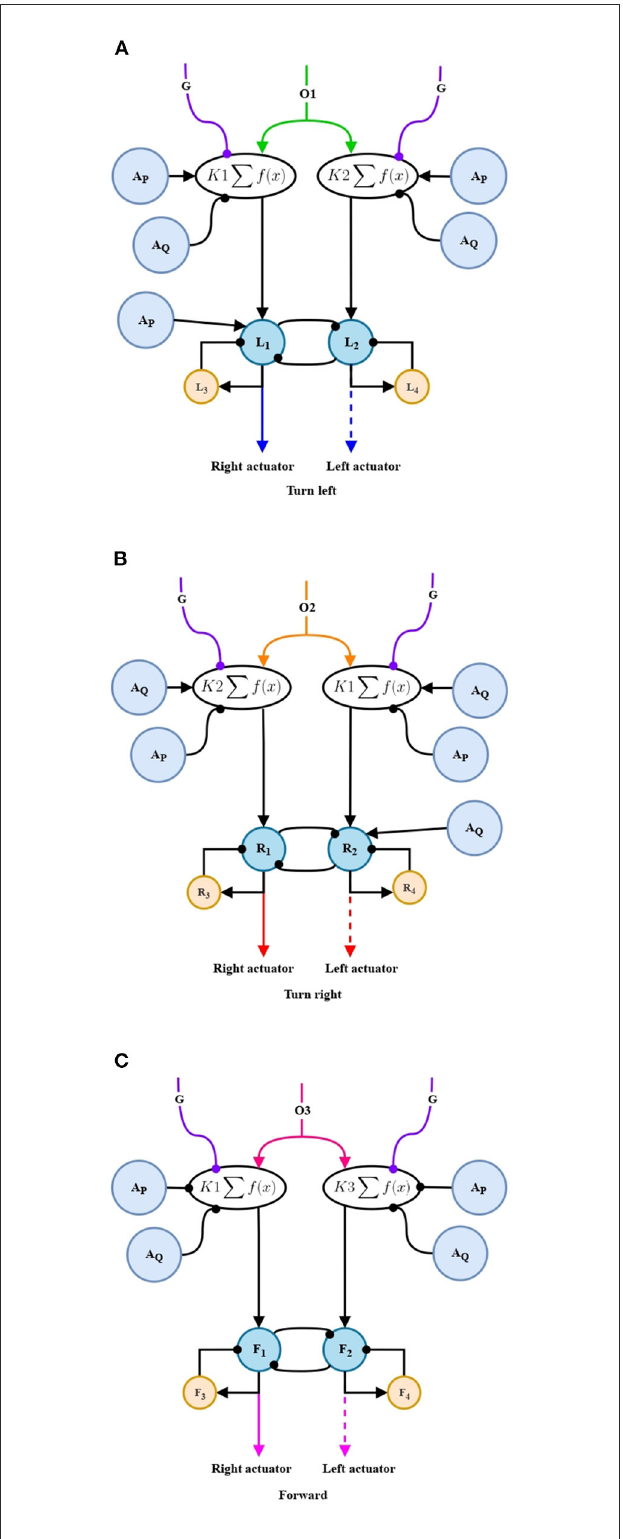
FIGURE8 Non-linear oscillation generator circuit. (A) Non-linear oscillation circuit for turning left. (B) Non-linear oscillation generator circuit for turning right. (C) Non-linear oscillation generator circuit for forward